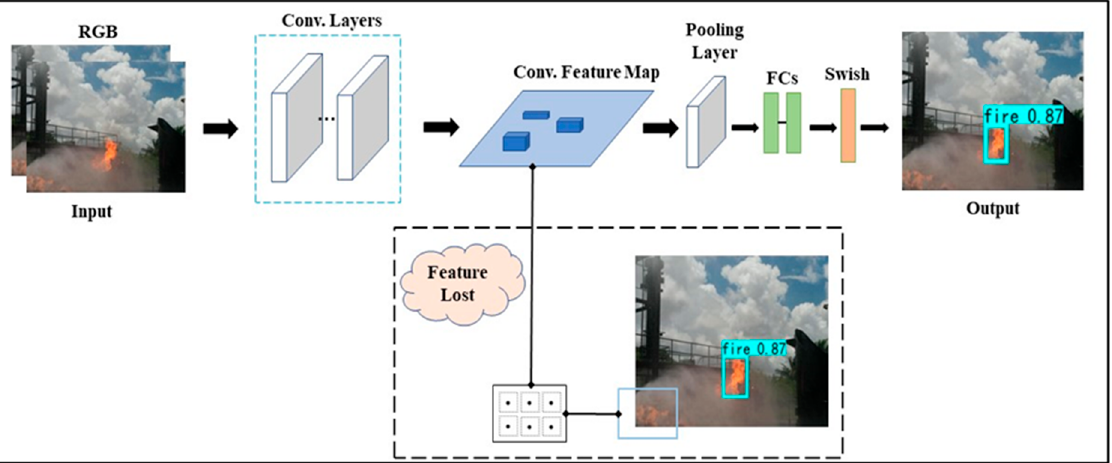
Figure 10. When the YOLOv6 model detects the concealed flame target, it is easy to lose features during model training, resulting in inaccurate detection results.